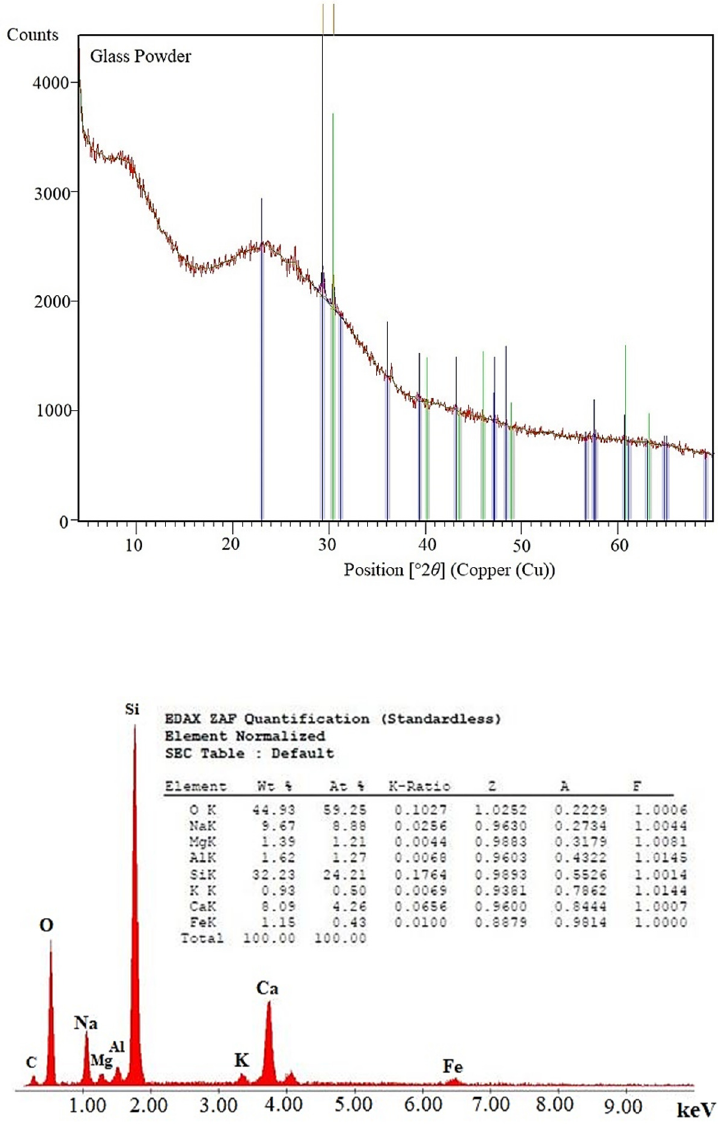
Figure 1. X-Ray pattern of glass powder ( above ); elemental Analysis of the glass powder ( below ). The SEM micrographs in Figure 2 show as-received waste glass powders and ground waste glass powders, highlighting their angular shape.